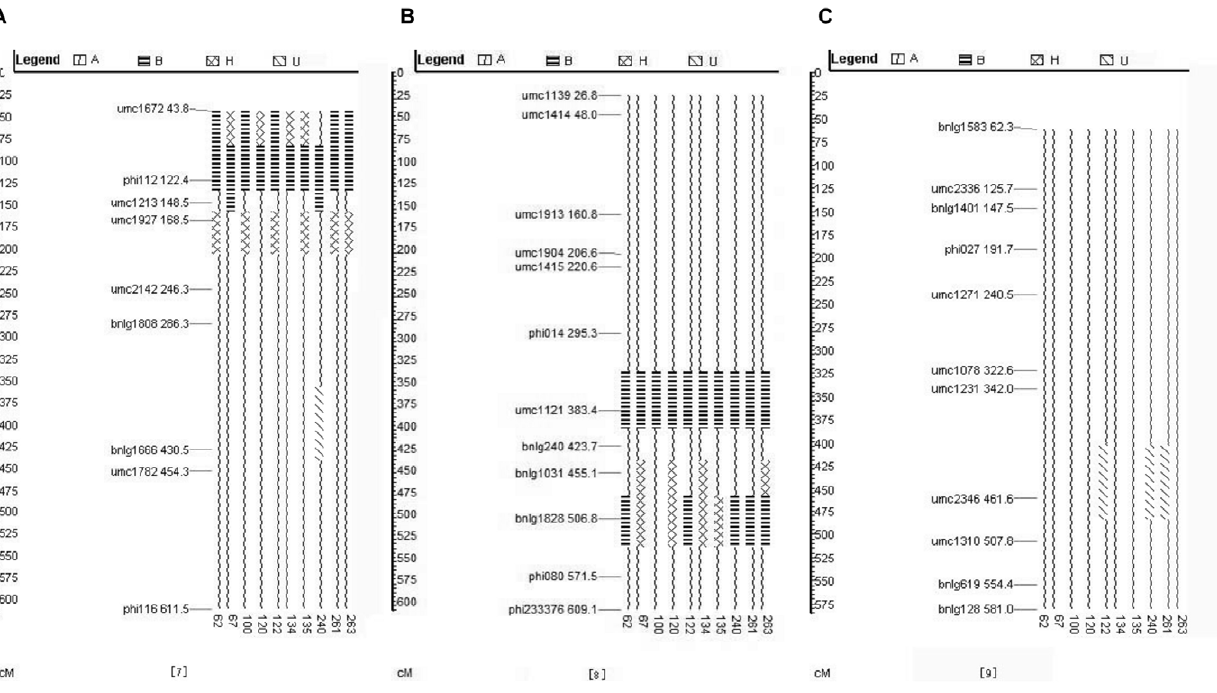
Figure 2. Graphical genotypes of 10 selected family lines in BC 2 F 3 on chromosomes 7, 8, and 9. (A) graphical genotype on chromosome 7; (B) graphical genotype on chromosome 8; (C) graphical genotype on chromosome 9.